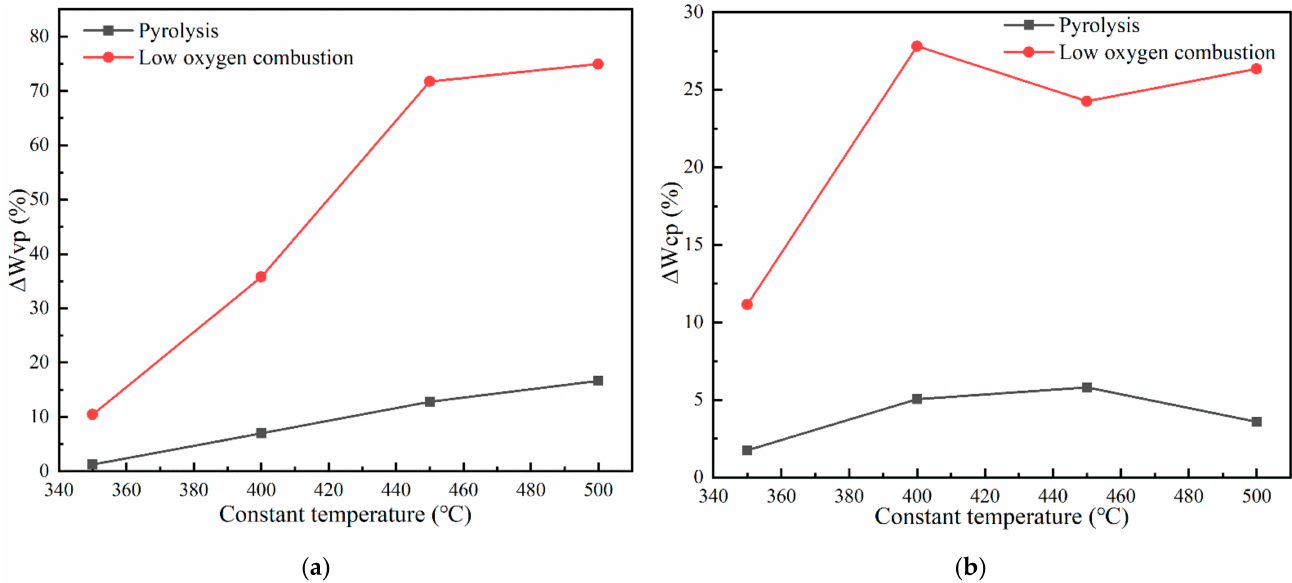
Figure 3. The variety law of parameter differences in different constant temperatures. ( a ) The parameter difference is residual weight difference during the temperature-rise period, ∆ Wvp . ( b ) The parameter difference is residual weight difference at the constant temperature period, ∆ Wcp